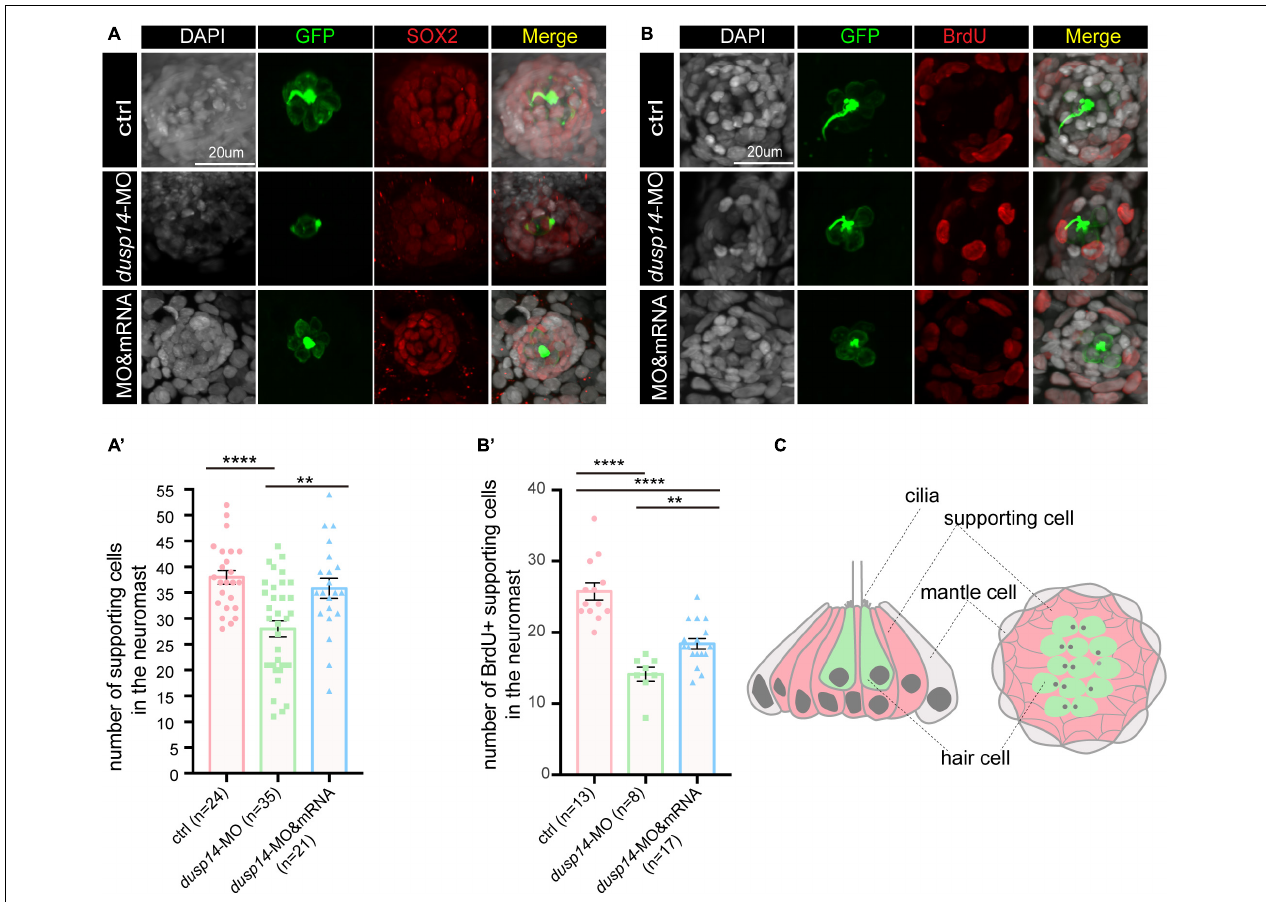
FIGURE 4 | Knockdown of the dusp14 gene reduces the number of supporting cells and proliferation of supporting cells. (A) The representation of SOX2 immunofluorescence images of neuromasts in the posterior lateral line of the control and dusp14 morphants. (A (cid:48) ) Quantification of the number of supporting cells in the posterior lateral line neuromast of control and dusp14 mutants at 72 hpf. (B) BrdU staining for the supporting cell in the neuromasts in the posterior lateral line of the control zebrafish and dusp14 morphants. Scale bar = 20 µ m. (B (cid:48) ) Quantification of zebrafish embryos with the BrdU + cells in the control and dusp14 morphants. (C) Schematic diagram of the longitudinal structure and the plane structure of neuromast, the gray part is the mantle cell, the pink part is supporting cell, and the green represents hair cell. Experimental embryos were sampled at 72 hpf ( n > 8). Each bar represents the mean ± SD. Values with ** and **** above the bars are significantly different ( P < 0.01 and P < 0.0001,